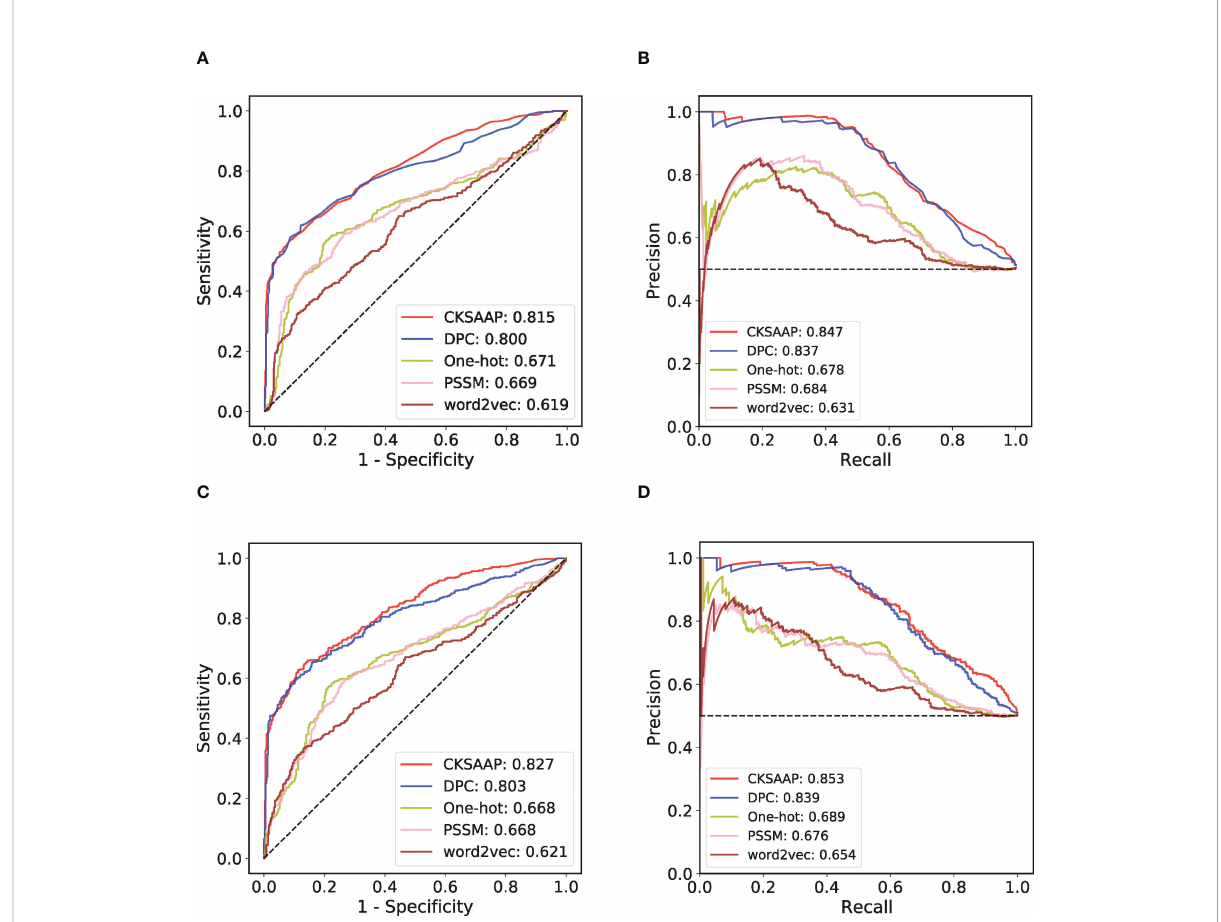
FIGURE 2 Performance comparison among different sequence encoding strategies in RF model and CNN model. (A) ROC curves of the fi ve-fold cross- validation (CV) with RF model. (B) PR curves of the fi ve-fold CV with RF model. (C) ROC curves of the fi ve-fold CV with CNN model. (D) PR curves of the fi ve-fold CV with CNN